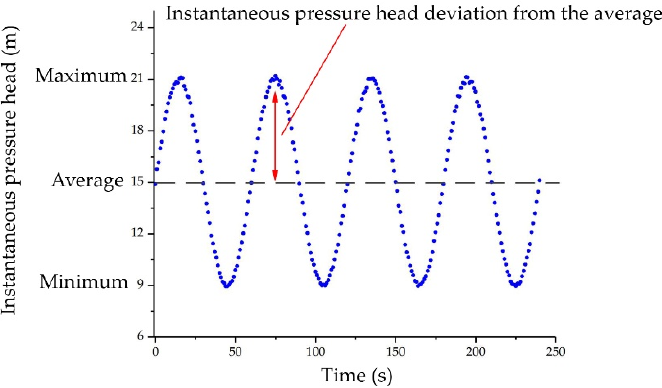
Figure 1. Instantaneous pressure head of oscillating water flow .